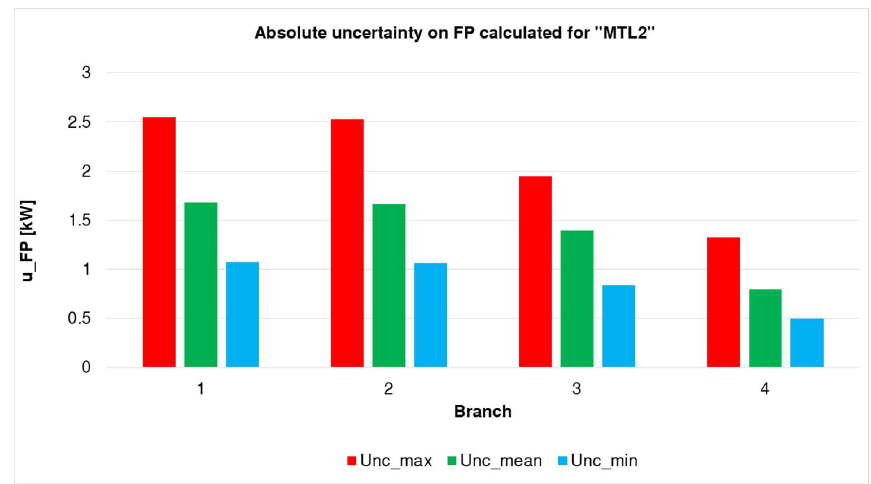
Figure 17. Maximum, average and minimum values of the absolute uncertainties in the calculated active power flows of the “MTL2” line (31 May 2018).